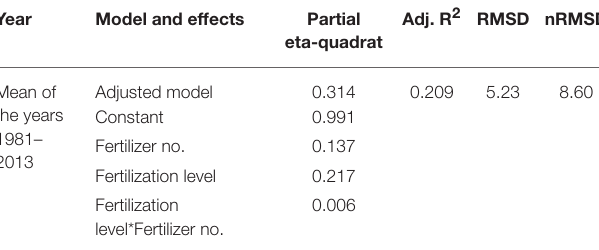
TABLE 5 | Modeling of the yield (means of the years 1981–2013) with ANOVA with the factors fertilization level and fertilizer number (see also Supplementary Table 2 for further information).